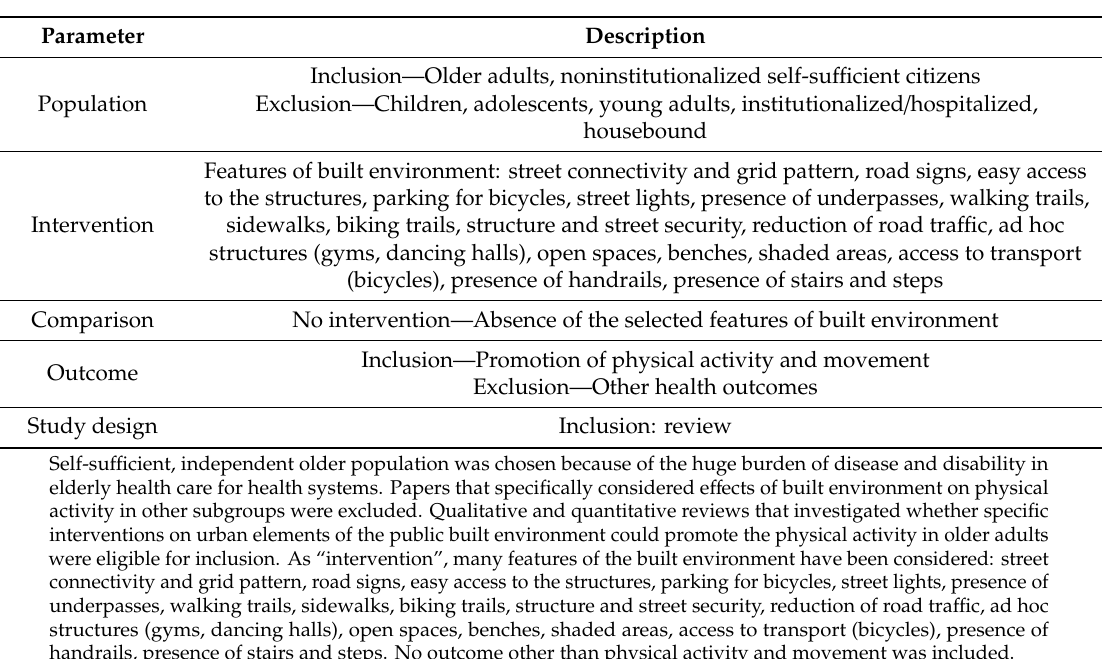
Table 1. PICOT (Population, intervention, comparison, outcome, type of study) scheme to define inclusion